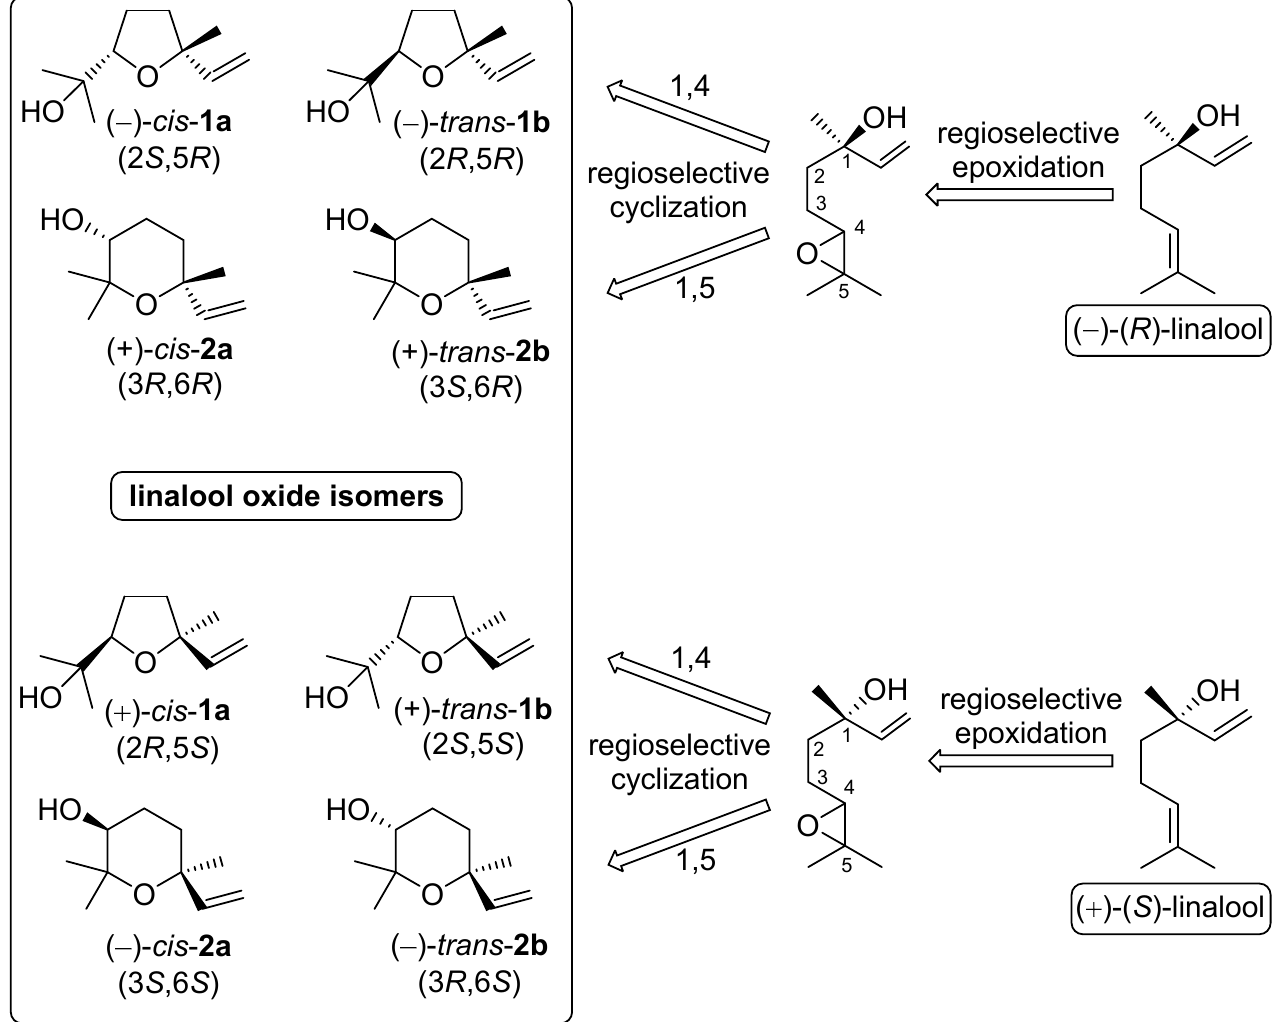
Figure 1. The eight linalool oxide isomers and their postulated biosynthesis from linalool enantiomers.